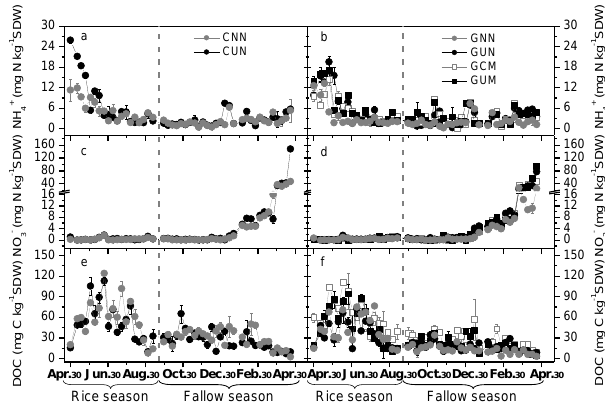
Fig. 2. Figure 2. Seasonal dynamics in (a–b) soil ammonium ) , (c–d) nitrate (NO − ) and (e–f) dissolved organic car- (NH + 4 3 bon (DOC) contents (mean ± standard error) for different fertilizer treatments in the conventional paddy and ground cover rice produc- tion systems during the rice–fallow rotation cycle of 2011–2012. SDW stands for soil dry weight. Definitions of abbreviations for the different fertilizer treatments are shown in the footnotes of Table 1 and in the